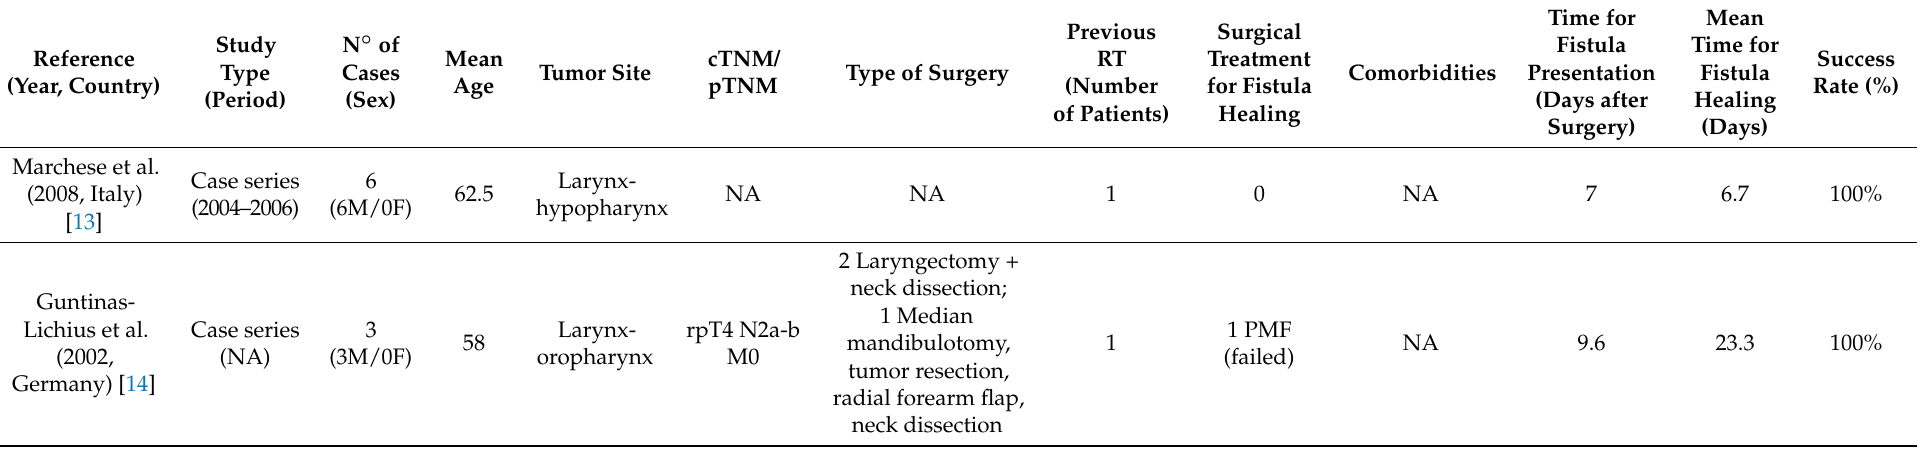
Table 3. Overview of the clinical outcomes of patients treated for PCF using botulinum toxin therapy. Acronyms: NA, not available; M, male; F, female; PMF, pectoralis major myocutaneous